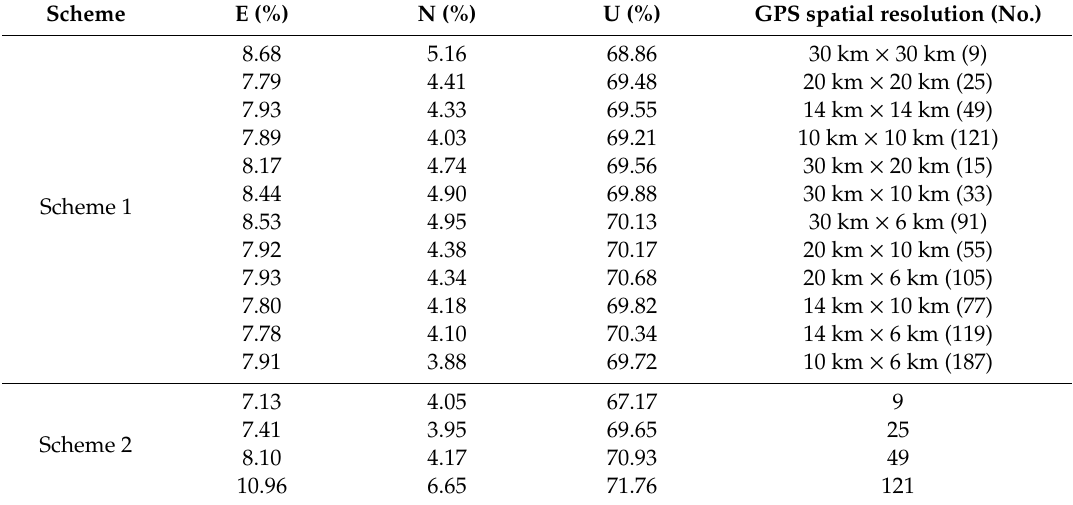
Table 2. The Per in the reverse fault for two schemes.